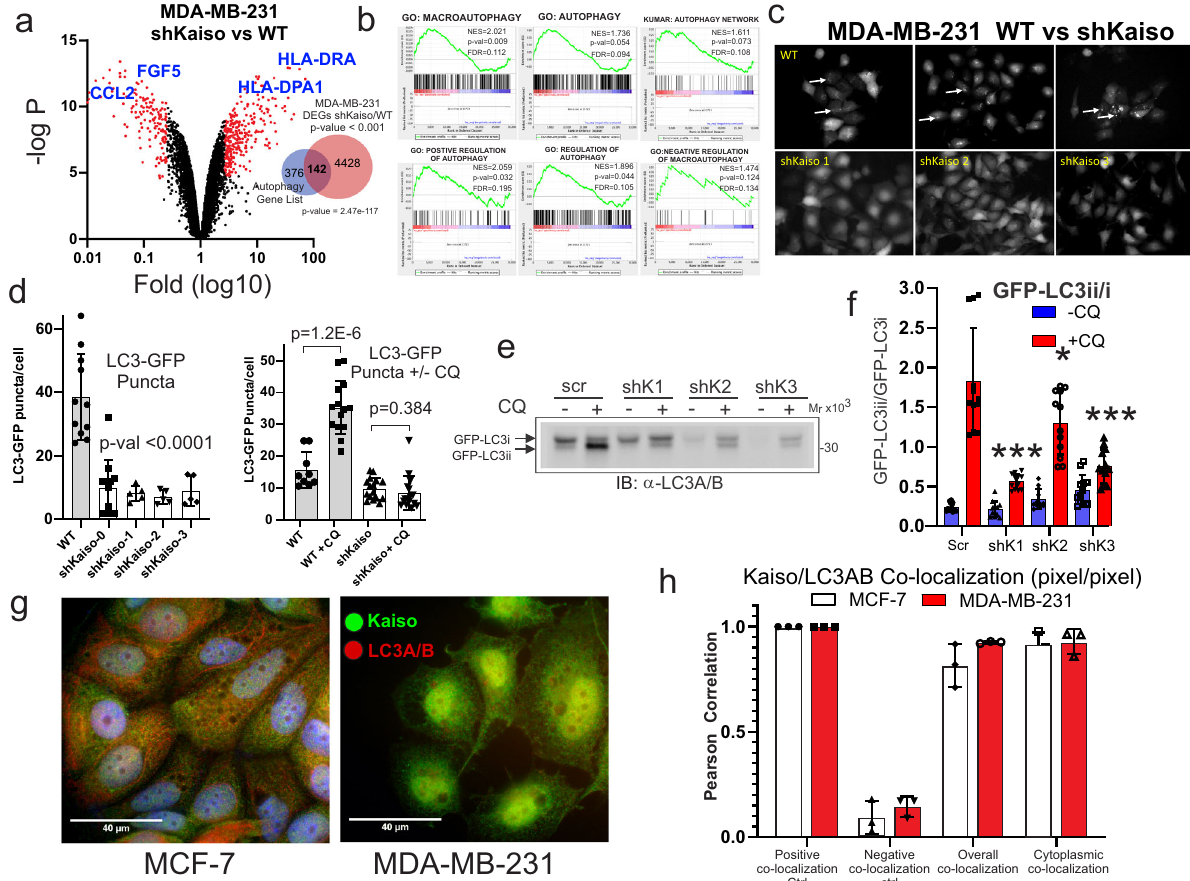
Fig. 4 Breast cancer cells depleted of Kaiso are enriched for autophagy terms and show a defect in LC3A/B maturation. a Differential gene expression analysis of wild type TNBC cell line MDA-MB-231 versus MDA-MB-231 cells depleted of Kaiso by RNAi shows a signi fi cant overlap of differentially expressed genes with an autophagy-related gene list (also see Supplementary Fig. 6, and Supplementary Table 3) ( p -value for the signi fi cance of the overlap is provided by the hypergeometric test). b Gene set enrichment analysis shows signi fi cant enrichment for autophagy terms in MDA-MB-231 cells that differentially express Kaiso (Supplementary Data 4). c Analysis of autophagocytic fl ux in WT versus MDA-MB-231 depleted of Kaiso by RNAi reveal a signi fi cant defect in autophagy demonstrated by decreased autophagocytic puncta formation in cells depleted of Kaiso. d Quantitative GFP-LC3 immuno fl uorescent analysis of LC3 puncta formation (average puncta per cell before (left) and after (right) addition of chloroquine in MDA-MB-231 cells expressing GFP-LC3). e Immunoblot analysis of LC3A/B lipidation (GFP-LC3ii formation) in MDA-MB-231 transfected with scramble control RNAi versus 3 different short hairpins against Kaiso. f Quantitative densitometer scan ( N = 4 biological replicates each with N = 3 technical replicates). (*) = p -value < 0.05, (***) = p -value < 0.001 ( t -test) for each unique Kaiso RNAi hairpin. g Immuno fl uorescent colocalization of Kaiso (green) and LC3A/B (red) in MCF-7 and MDA-MB-231 cells. h Quantitative pro fi ling of Kaiso and LC3A/B colocalization in both the cytoplasm and nucleus (overall) of MCF-7 and MDA-MB- 231